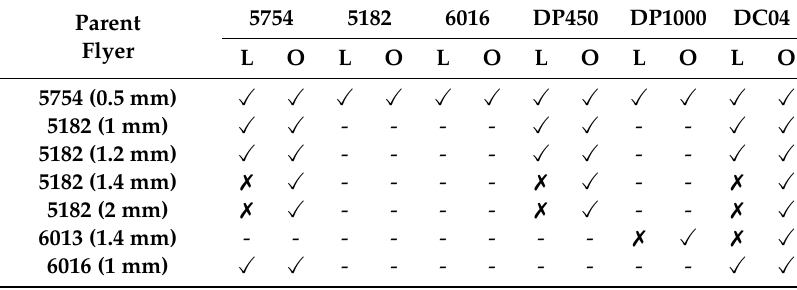
not welded / (cid:88) : welded / -: not